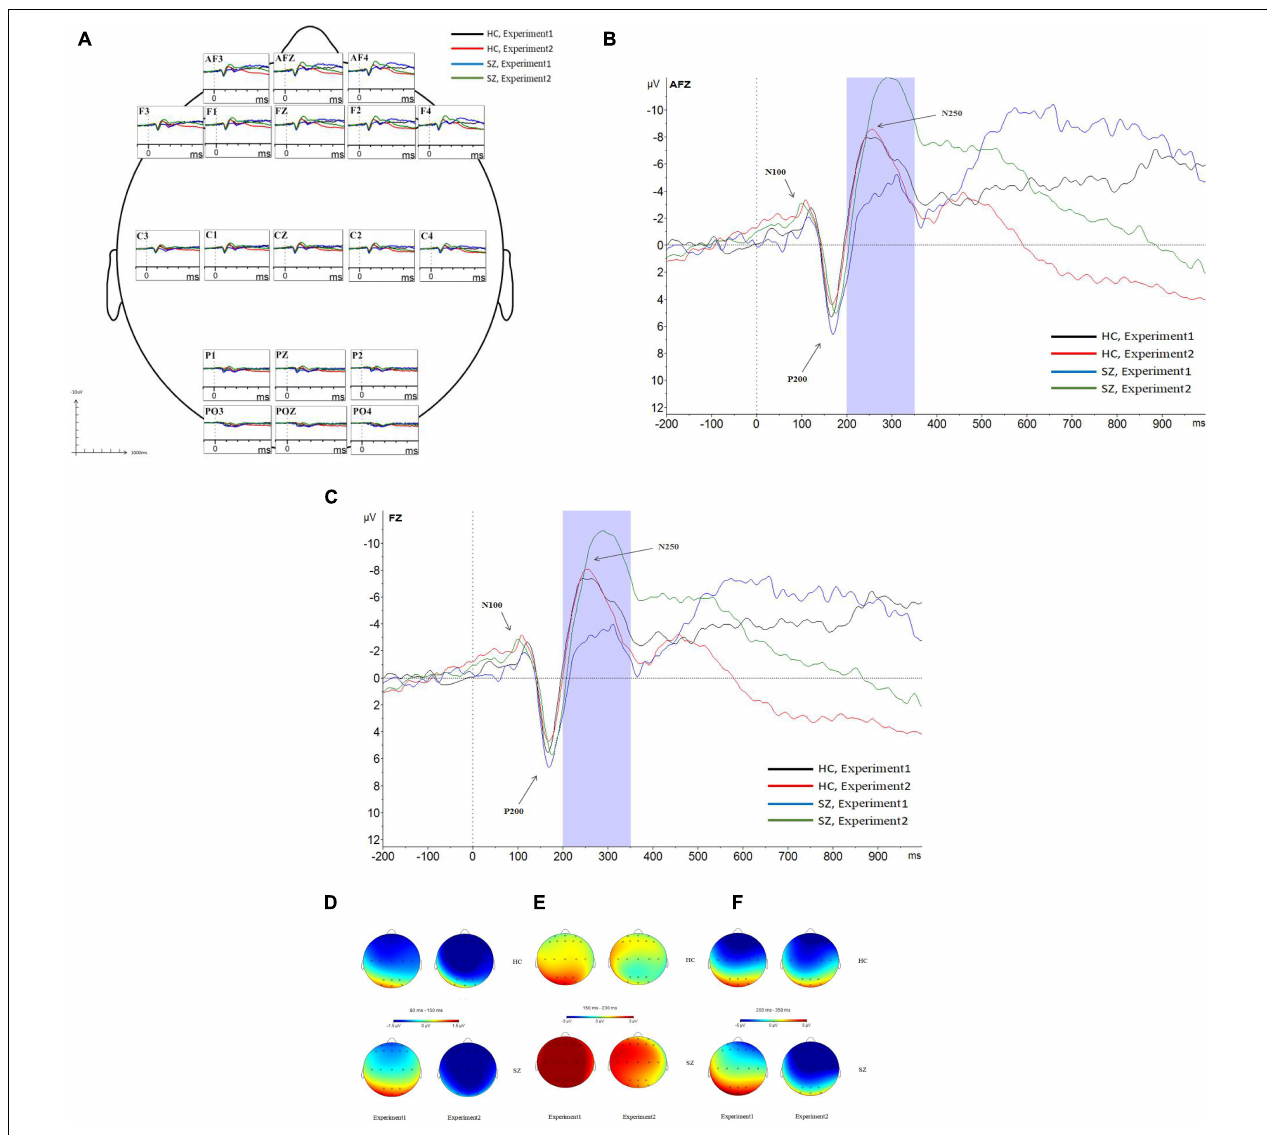
FIGURE 6 | Grand average event-related potentials (ERPs) at the AF3, AFz, AF4, F1, F2, Fz, F3, F4, C1, C2, Cz, C3, C4, P1, Pz, P2, PO3, PO4, and POz sites for all participants during experiment 1 and experiment 2 (A) . Following stimulus onset, the N100 component was measured in a time window within 80–150 ms, the P200 component was measured in a time window within 150–230 ms, and the N250 component was measured in a time window within 200–350 ms. In experiment 2, N250 amplitudes at the prefrontal site and frontal site in the SZ group were larger than those of the HC group; N250 latencies in the SZ group were longer than those of the HC group (B,C) . Topographic distributions of the N100 components (D) , P200 components (E) , and N250 components (F) in the SZ group and HC group. SZ, schizophrenia; HC, healthy control.